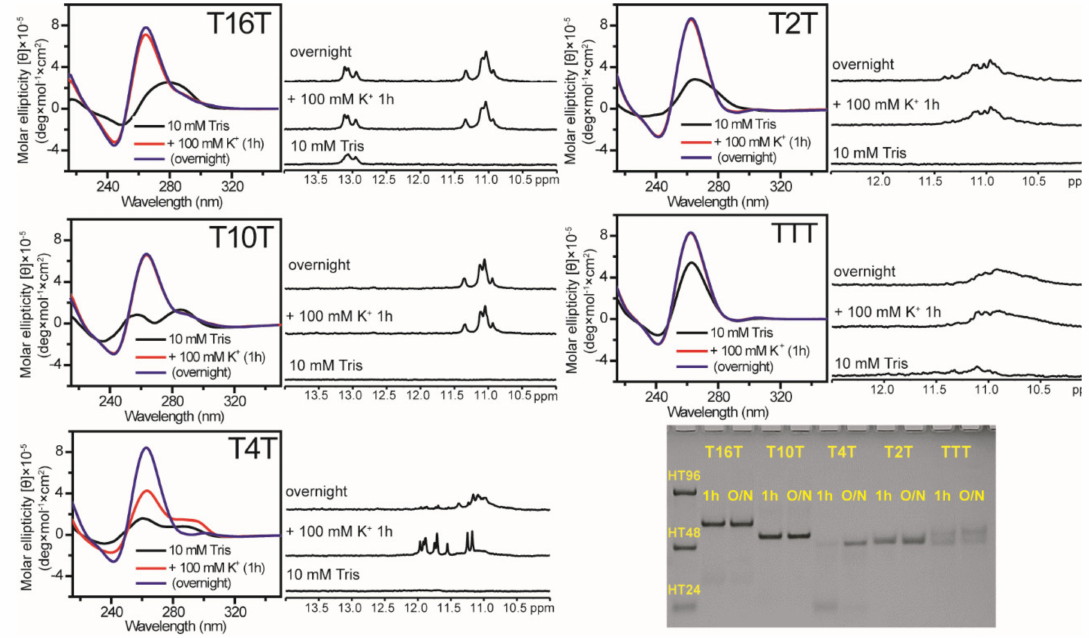
Figure 2. The e ff ect of loop length on G4 formation of (G 3 TG 3 N m G 3 TG 3 ) sequences. CD and NMR spectra of T16T, T10T, T4T, T2T, and TTT in 10 mM Tris and after 1 h and overnight (O / N) addition of 100 mM K + together with their PAGE assays of marker bands of HT24 (T 2 AG 3 ) 4 , HT48 (T 2 AG 3 ) 8 , and HT96 (T 2 AG 3 ) 16 (lane 1) and each sequence after 1 h and O / N addition of 100 mM K + for T16T, T10T, T4T, T2T, and TTT. The same DNA concentration of 100 µ M was used in the experiments of CD, NMR and PAGE of this